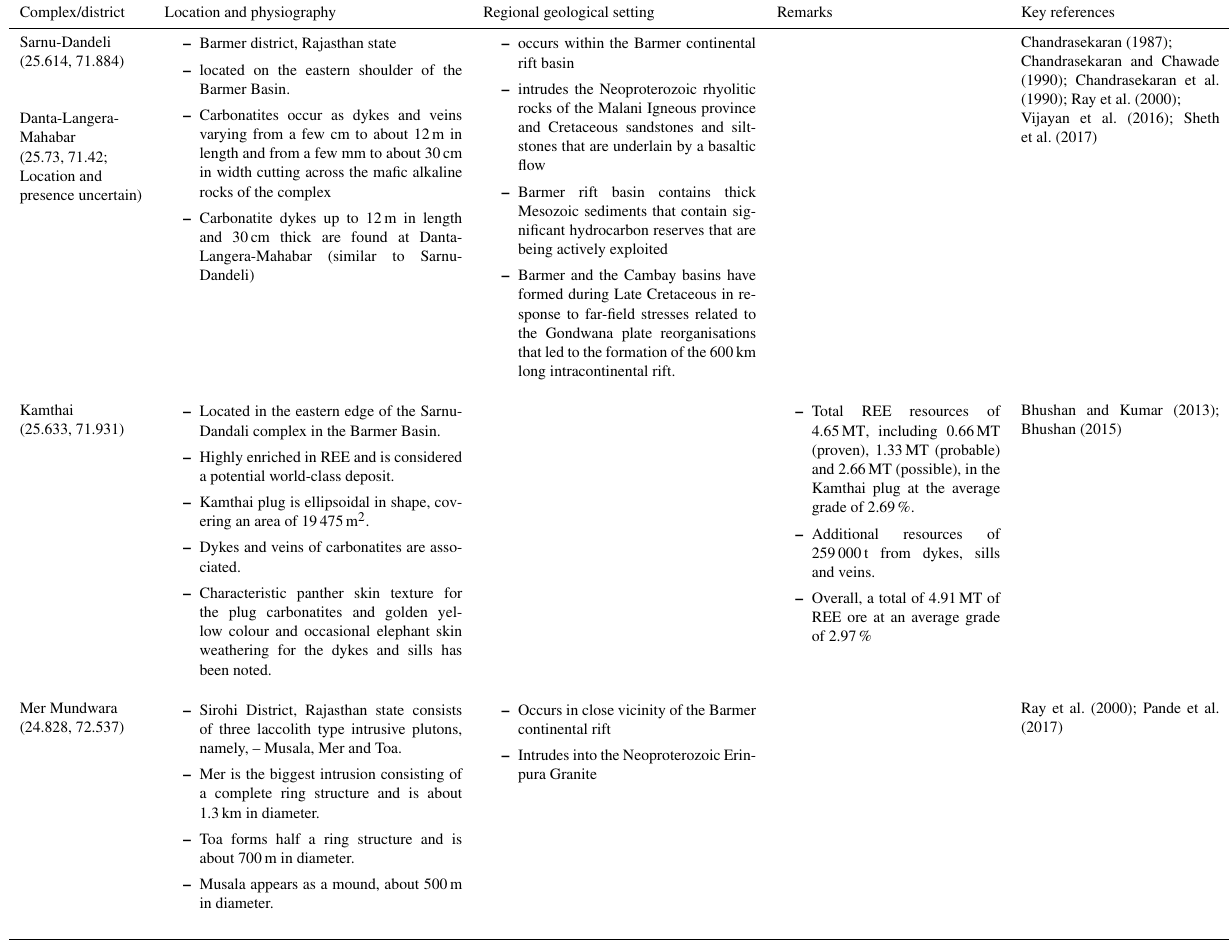
Table A1. Location, physiography and geological setting of carbonatite–alkaline complexes in NW India. Complex/district Location and physiography Regional geological